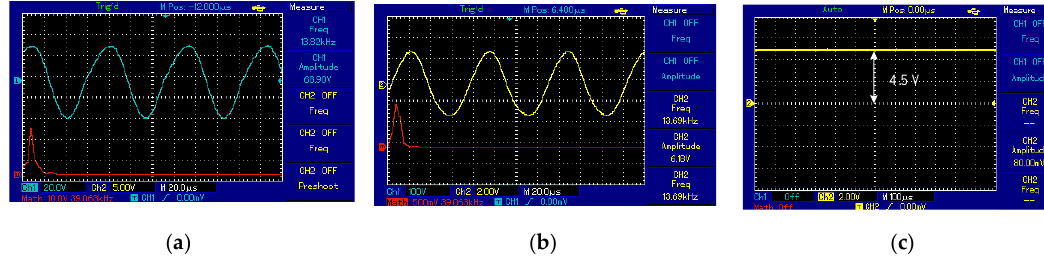
Figure 10. The voltage waveforms using the first topology at 9 cm for the measurement unit: ( a ) transmitter coil, ( b ) receiver coil, and ( c ) voltage load. transmitter coil, ( b ) receiver coil, and ( c ) voltage